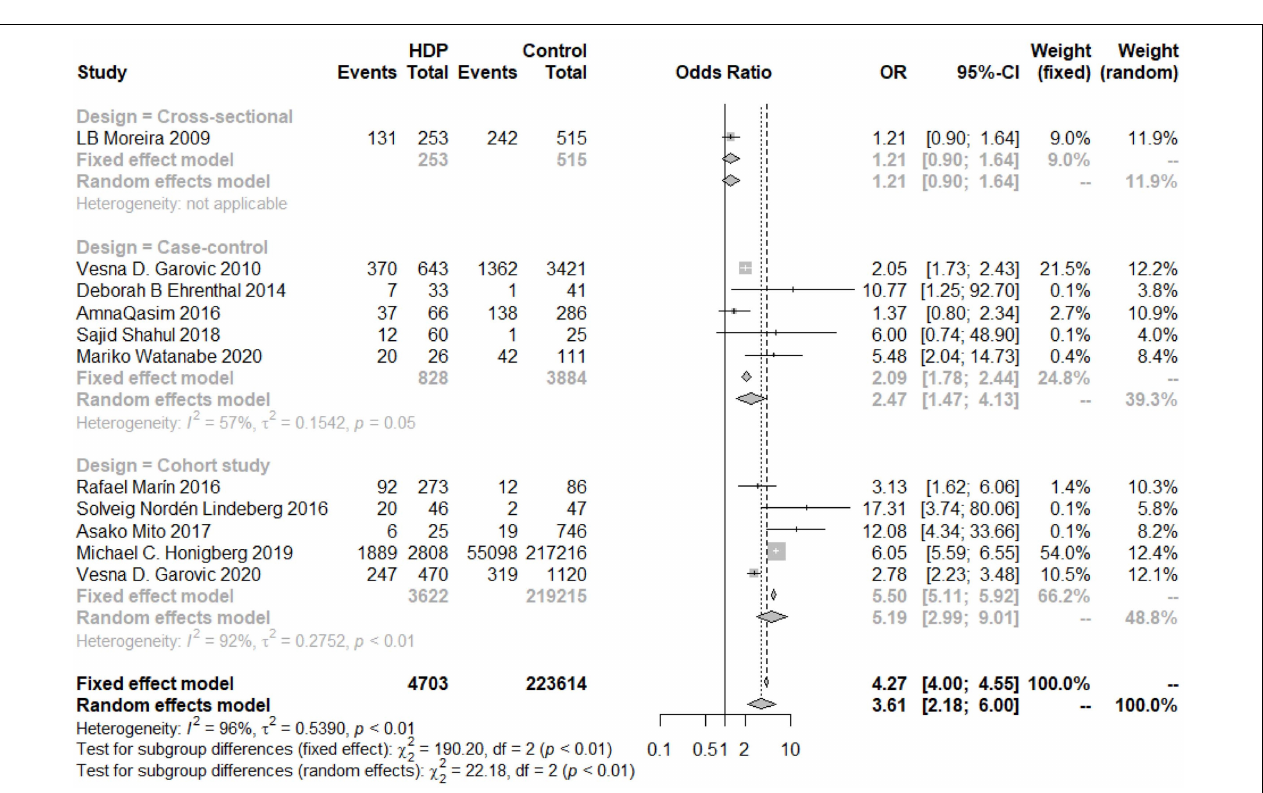
Frontiers in Cardiovascular Medicine |